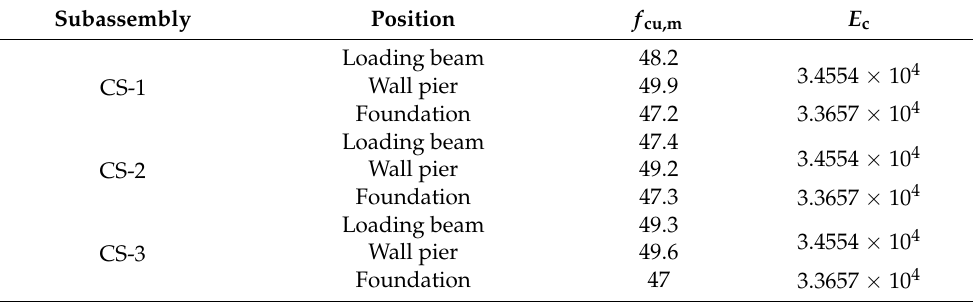
Table 2. Mechanical properties of concrete (unit: MPa).